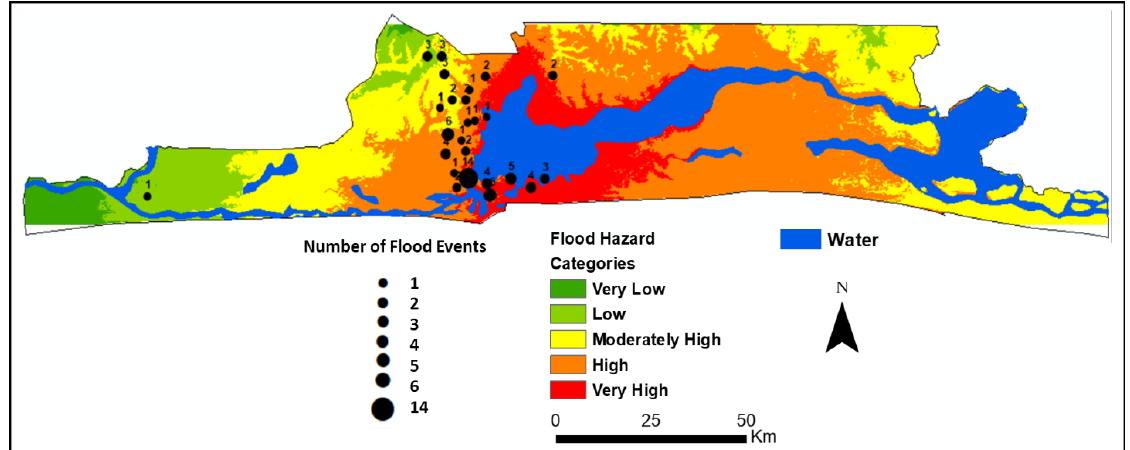
Figure 8. Flood hazard map with the number of flood events and past flood inventory points. Table 6. Percentages of the flood inventory points within the flood hazard categories.